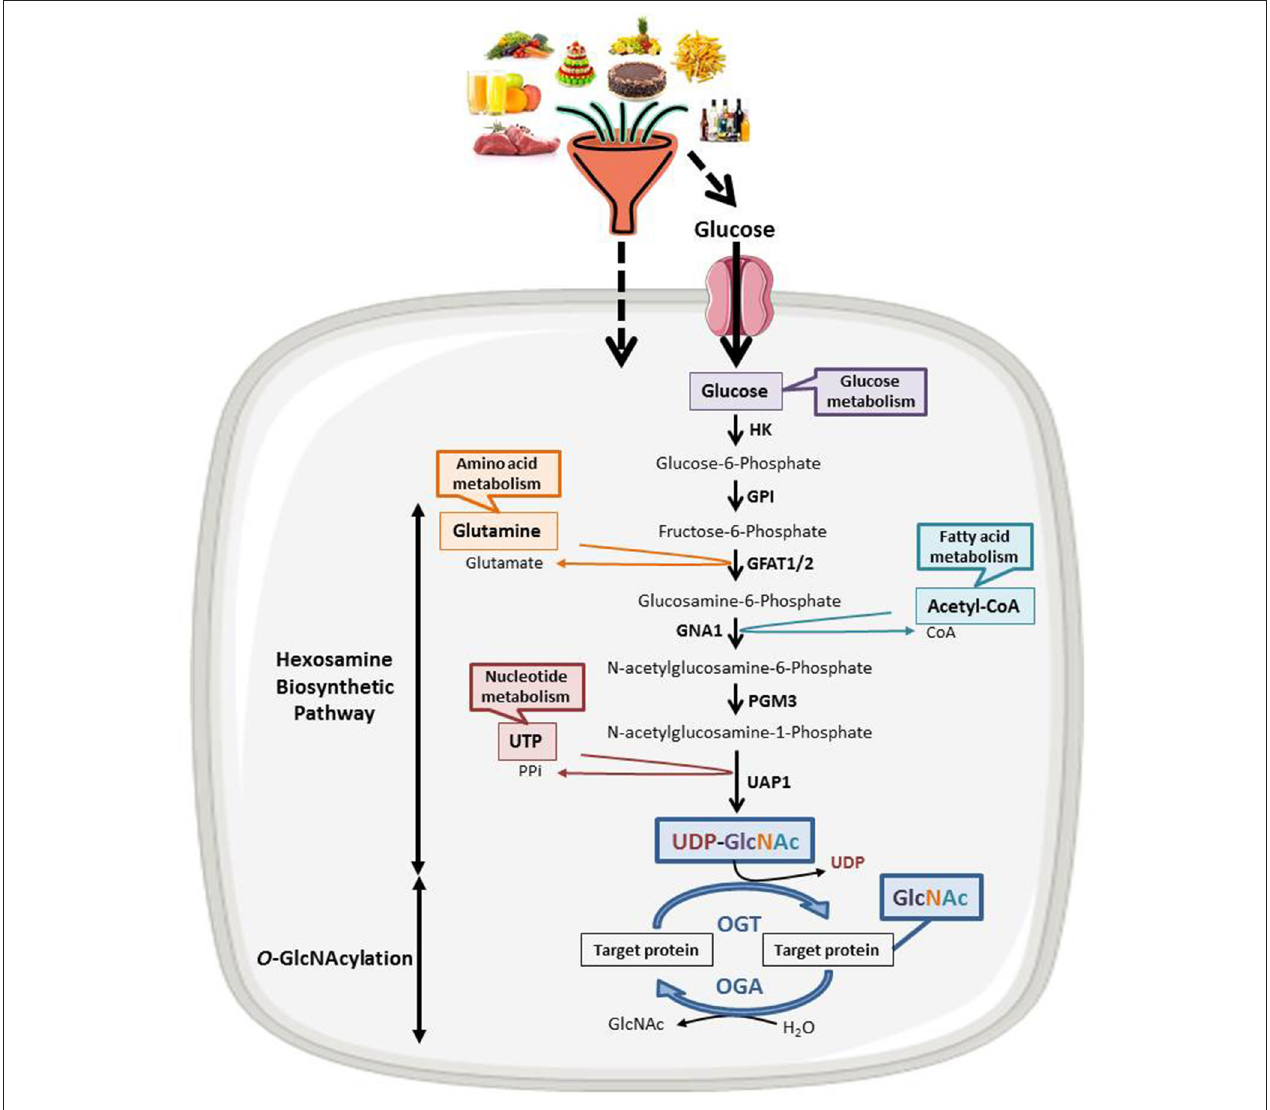
FIGURE 1 | The nutritional sensing O -GlcNAcylation. UDP-GlcNAc, OGT’s nucleotide sugar donor, is provided by the Hexosamine Biosynthetic Pathway (HBP) at the crossroad of glucose, amino acids, fatty acids and nucleotides metabolisms. UDP-GlcNAc levels are thus tightly correlated to the nutritional status of the organism. O -GlcNAcylation levels are regulated by a unique couple of enzymes: OGT that catalyzes the transfer of GlcNAc from UDP-GlcNAc onto the target protein and OGA that hydrolyzes the residue. HK, hexokinase; GPI, glucose-6-phosphate isomerase; GFAT, fructose-6-phosphate amidotransferase; GNA1, Glucosamine 6-phosphate N-acetyltransferase; PGM3, phosphoacetylglucosamine mutase; UAP1, UDP-N-acetylhexosamine pyrophosphorylase.